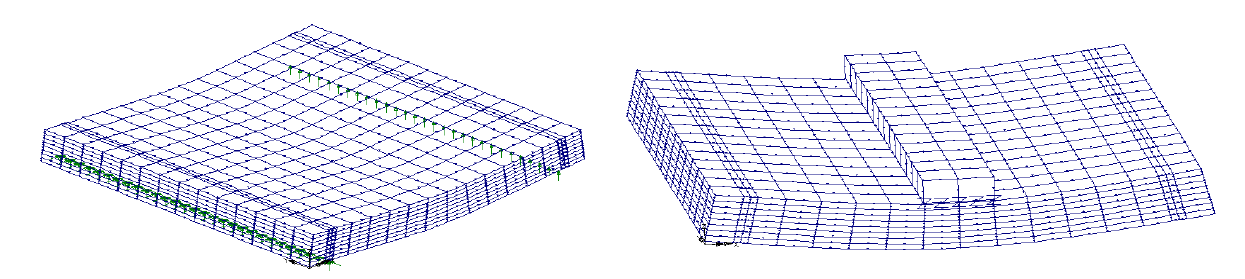
Figure 20: Deformed scheme for the control specimen Figure 21: Deformed scheme for the strengthened